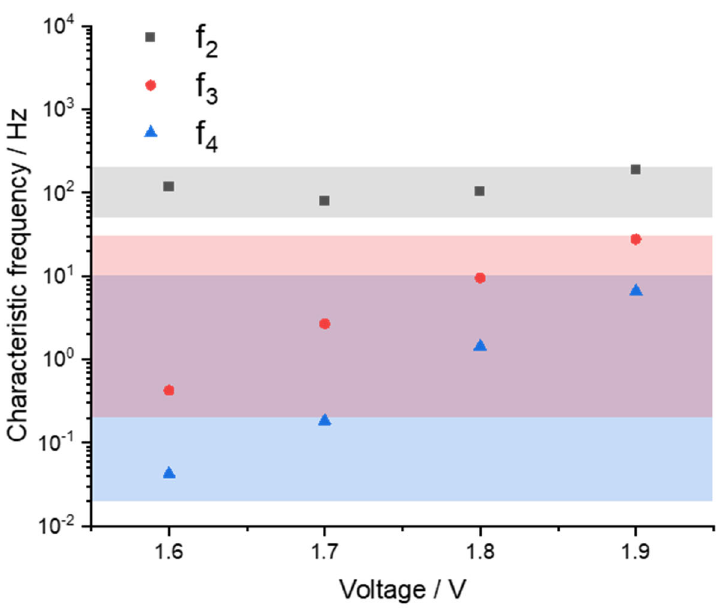
Figure 6. Characteristic frequencies related to the high-, mid-, and low-frequency arcs, calculated for a voltage range of 1.6–1.9 V (50 ◦ C, 1 M KOH) (presented as dots); the filled area relates to the high-, mid-, and low-frequency arcs colored with black, red and blue, respectively. Filled areas are given considering the f i variation with temperature.